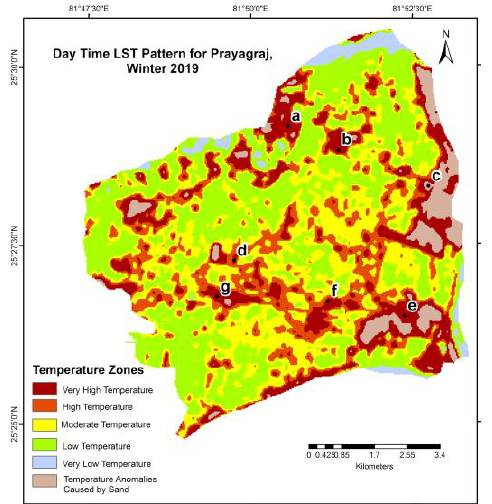
Figure 6. Day time LST and UHI of Prayagraj in winter, 2019